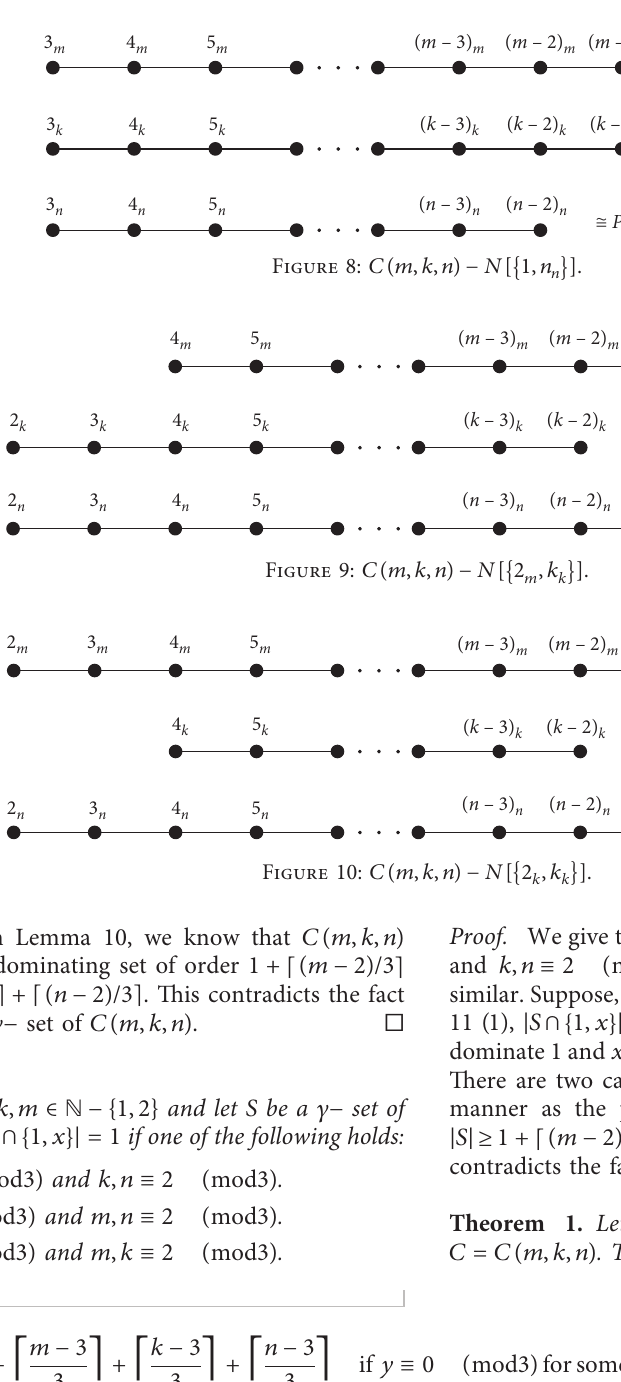
Figure 8: C ( m,k, n ) − N [ 1 ,n